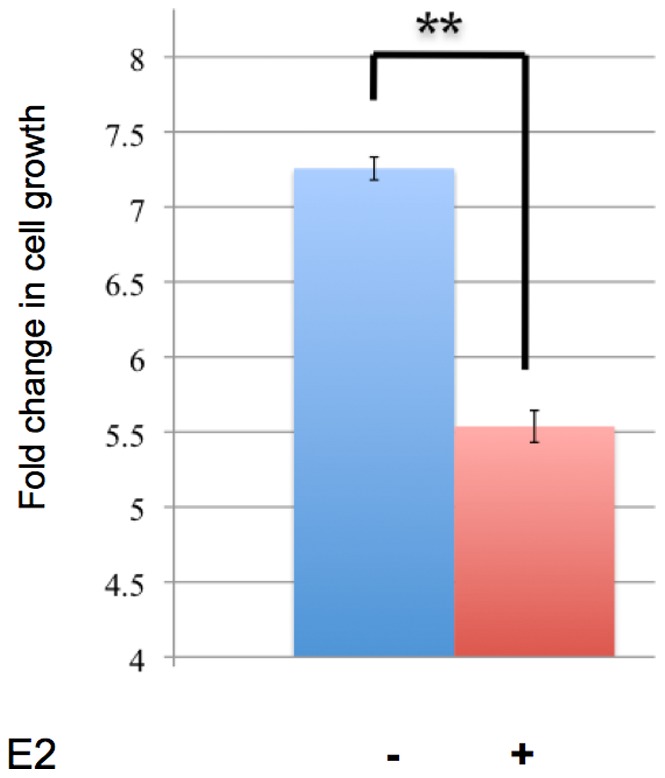
ERβ negatively regulates cell proliferation in an E2 dependent-manner.C4–12/Flag.ERβ cells were treated with 10 nM E2 for 3 days. Cell confluency, detected by the Incucyte FLR live content imaging system (Essen Bioscience), was used to measure cell proliferation. Bar graph represents fold change relative to day 0. (Error bar = standard deviation).